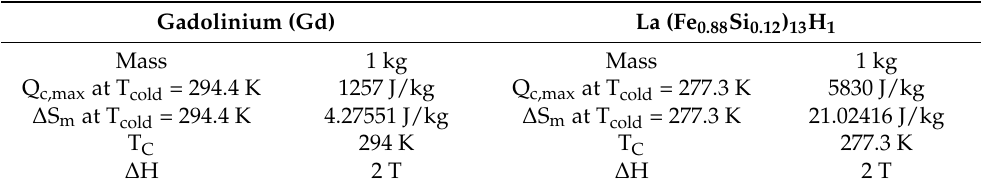
Table 1. Experimental data and results of both magnetocaloric